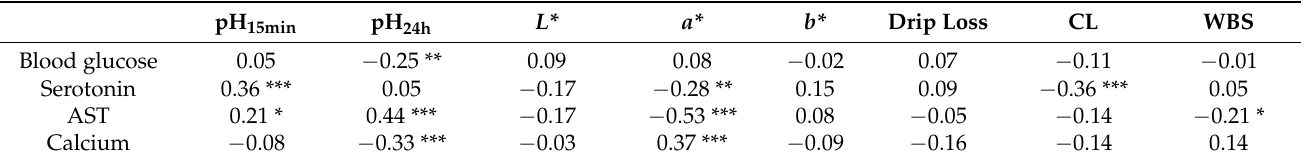
Table 3. Correlation coefficients between the serum biochemical parameters and meat quality traits of